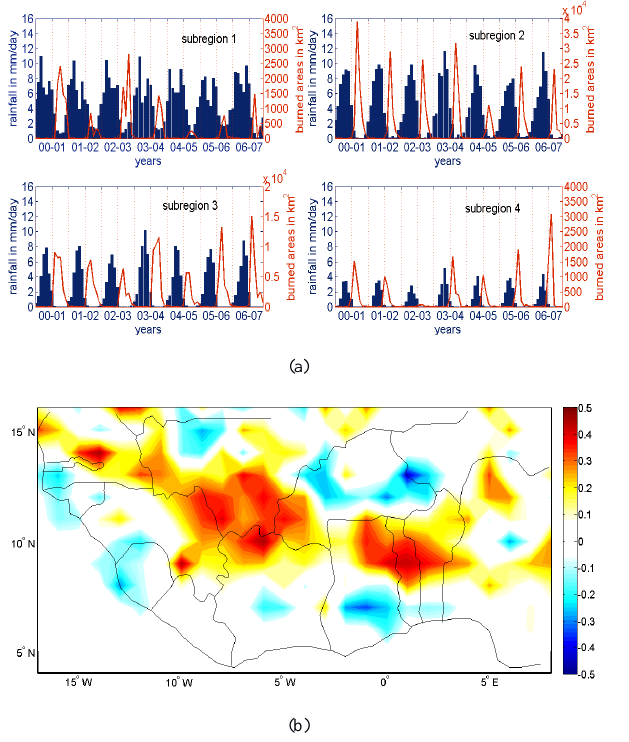
Figure 8. Rainfall and fires over the West African domain. (a) Time series between rainfall and burned areas for each of the four subregions, and (b) Spatial correlation map between burned areas and JJAS rainfall of the preceding years over West Africa. Note that burned area axis bounds vary between subregions.